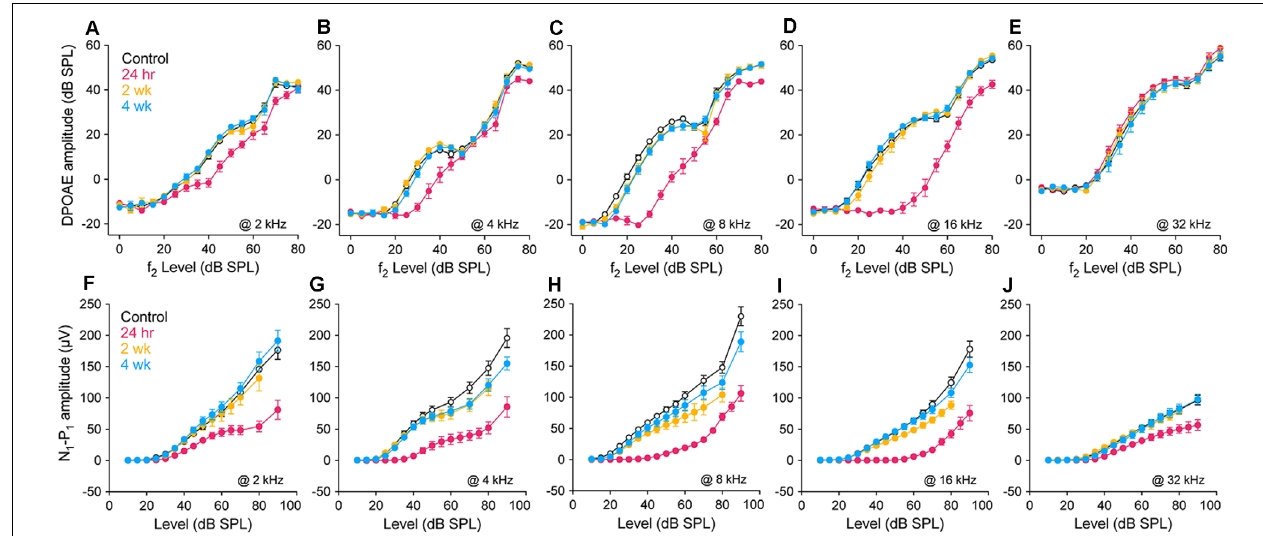
FIGURE 2 | Suprathreshold response amplitudes. Amplitude vs. stimulus level functions for DPOAEs (L2 = 0–80 dB SPL) and CAPs (10–90 dB SPL) in unexposed and exposed gerbils 24 h, 2 wk and 4 wk after noise. 2f1-f2 DPOAE (A–E) and N1-P1 of the CAP (F–J) at 2, 4, 8, 16, and 32 kHz. All data points are group means ± SEM; group sizes are as given in the Figure 1 caption. Statistical tests were performed for amplitude data at 4, 8 and 16 kHz, at 30 dB SL to facilitate comparison with peri-stimulus time response (PSTR) responses shown in Figure 6 . Control vs. exposed groups (alpha = 0.05): DPOAE amplitudes differed at 8 kHz ( p < 0.001) and 16 kHz ( p < 0.001) but not 4 kHz ( p = 0.07); N1-P1 amplitudes were reduced in exposed groups at all three frequencies ( p < 0.001). 24 h vs. 2 wk, 4 wk (alpha = 0.025): DPOAE amplitudes were significantly different at 8 and 16 kHz ( p < 0.001 for both) but not at 4 kHz ( p = 0.37); N1-P1 amplitudes recovered significantly with post-exposure time at 4, 8, and 16 kHz ( p < 0. 001 at each frequency). Control vs. 2 wk, 4 wk (alpha = 0.025): DPOAE amplitudes of the exposed groups were less than control at 8 kHz ( p = 0.018) but not at 4 or 16 kHz ( p = 0.20 and p = 0.64, respectively); similarly, neural responses of the exposed groups were less than control at 8 kHz ( p = 0.02) but not at 4 or 16 kHz ( p = 0.16 and p = 0.28, respectively). Two week and 4 wk amplitudes were not different at 4, 8, or 16 kHz in the DPOAE ( p = 0.65, p = 0.91, and p = 0.54) or the N1-P1: ( p = 0.86, p = 0.25, and p = 0.07)